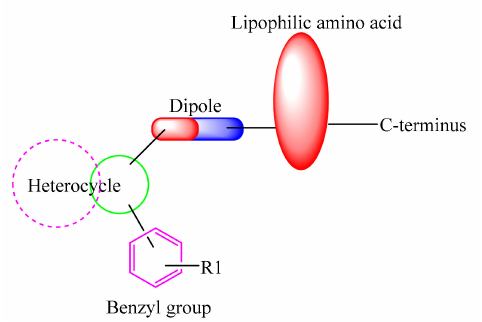
Figure 9. Structural features of the synthetic cannabinoids reported in this